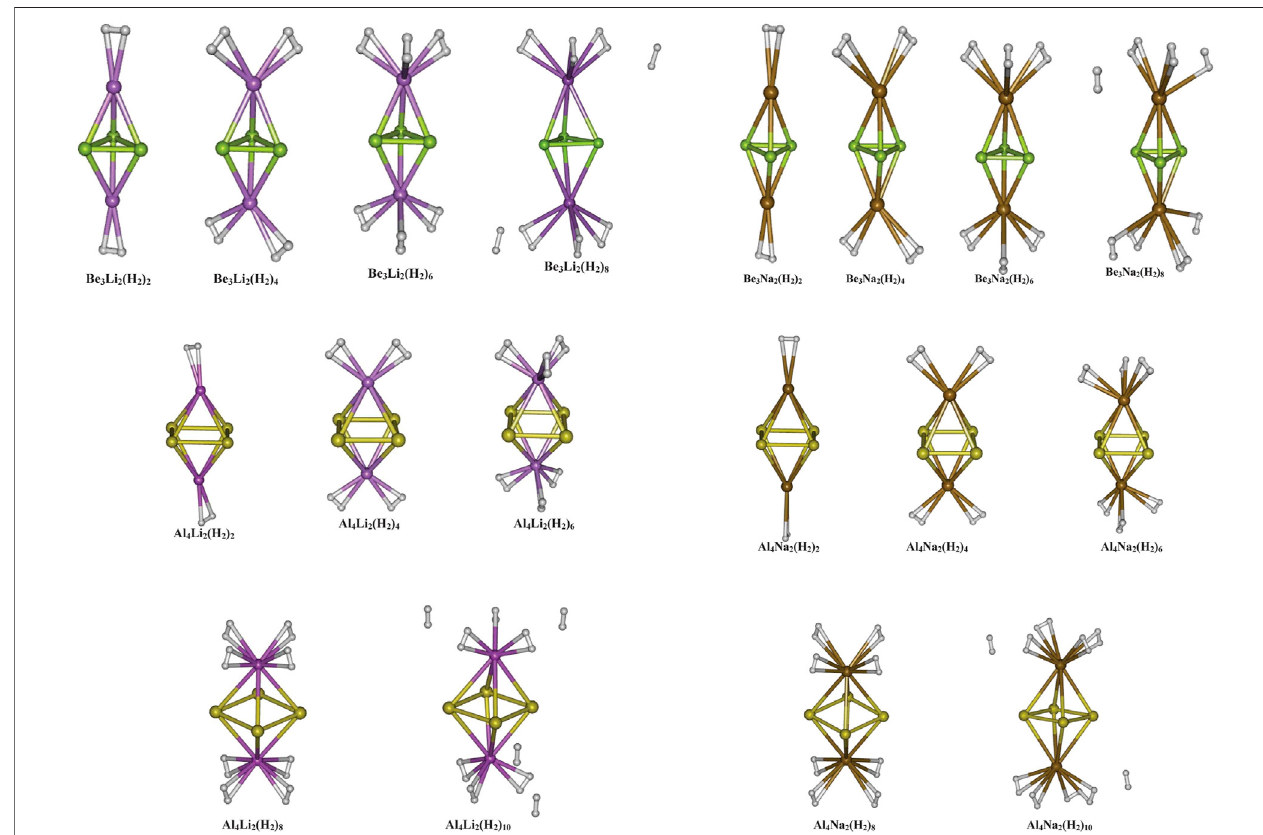
FIGURE 3 | Optimized geometries of the hydrogen loaded Be 3 M 2 , and Al 4 M 2 (M (cid:1) Li, and Na) systems (Reproduced from Srinivasu et al., 2012 with permission from the Royal Society of Chemistry).